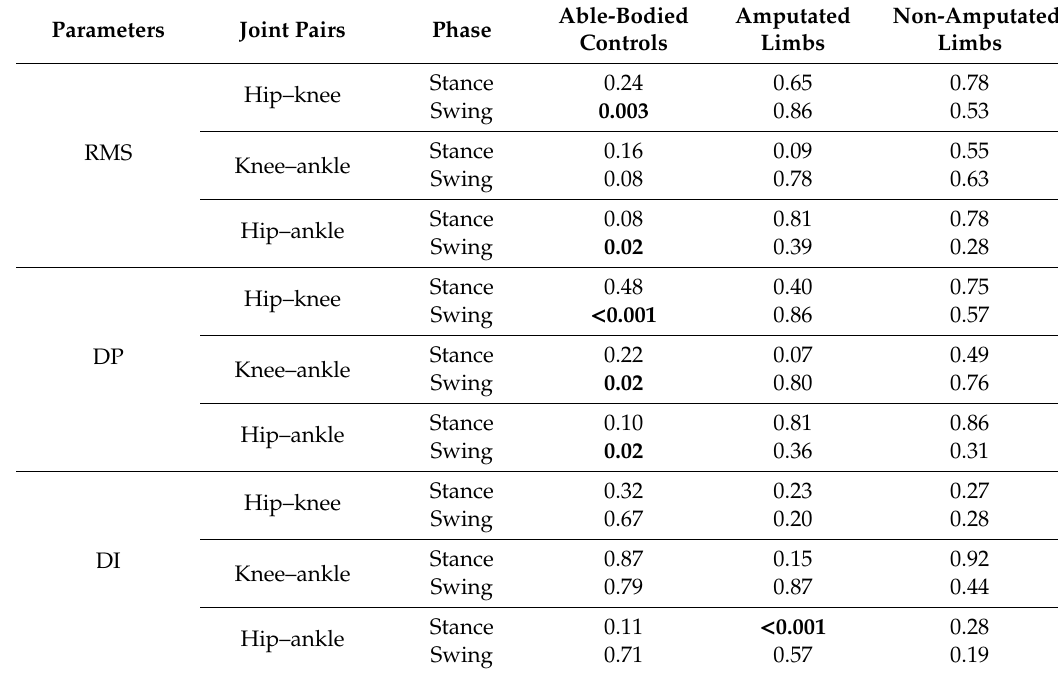
Table 2. Significance level of the Shapiro–Wilk test to check for data